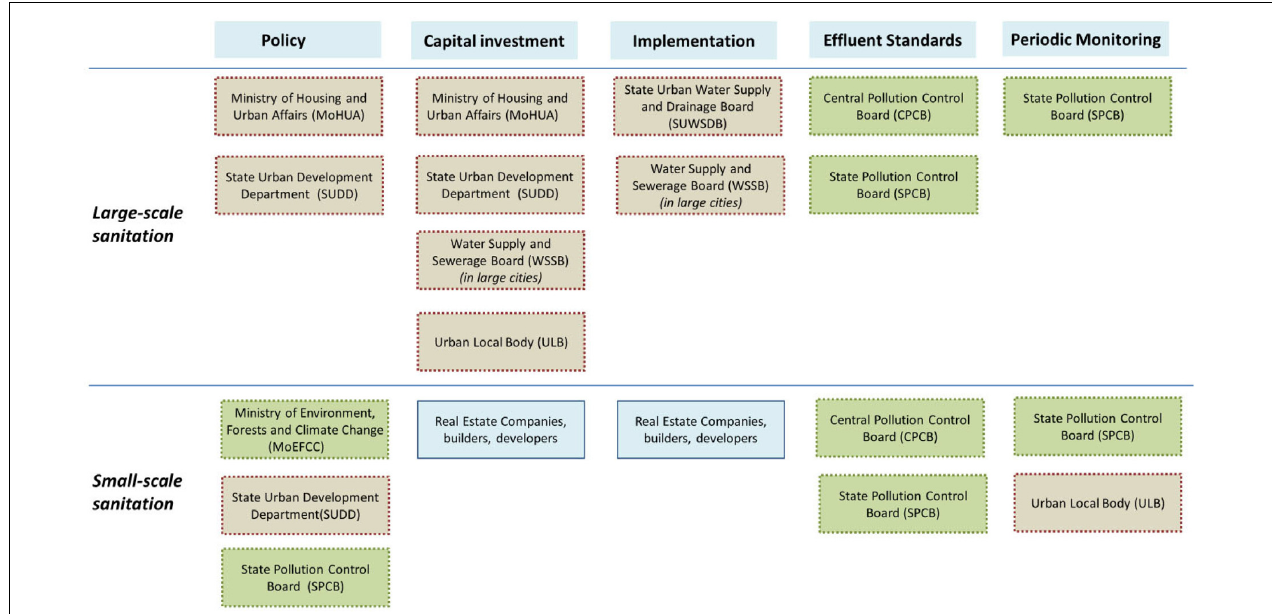
FIGURE 2 | Comparison of responsibilities in the large-scale and small-scale sanitation sectors; the governmental agencies highlighted in brown fall under MoHUA and the ones in green under